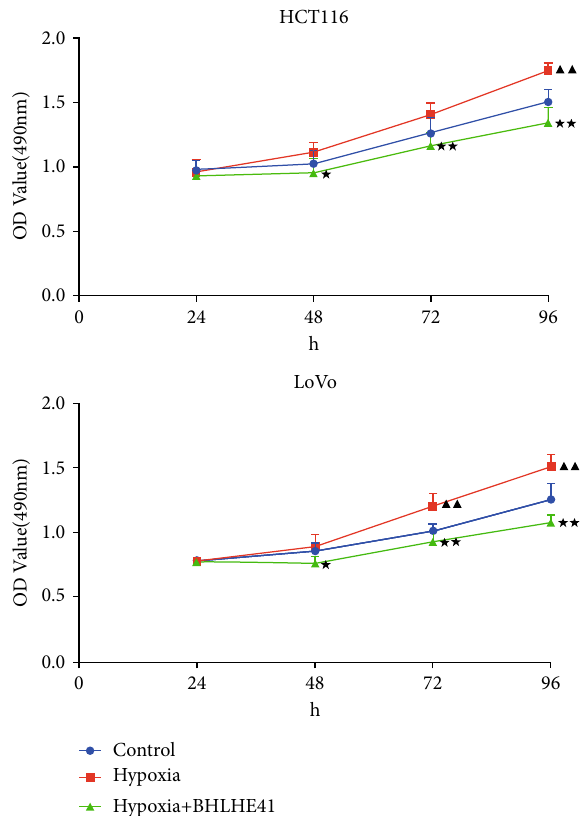
Figure 3: BHLHE41 overexpression repressed the cell viability in hypoxia-induced CC cells. The cell viability in hypoxia-induced CC cells was tested by CCK-8. All experiments have been performed in triplicate, and data were expressed as mean ± SD . ∗ P < 0 : 05 , ∗∗ P < 0 : 01 vs. hypoxia; ▲▲ P < 0 : 01 vs.